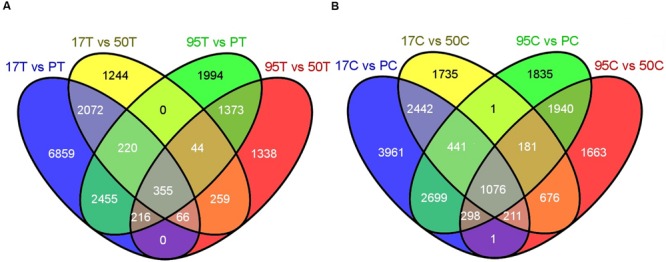
(A) Number of differentially up-regulated (DUR) transcripts in inoculated resistant lines (17T and 95T) compared to the inoculated susceptible lines (PT and 50T). (B) Number of DUR transcripts in uninoculated resistant lines (17C and 95C) compared to the uninoculated susceptible lines (PC and 50C). 17, 50, 95 and P refer to NE BG 7-3459-17, NE BG 7-3453-50, 95-55 and Prestige, respectively. C and T indicate untreated and treated samples, respectively. The Venn diagrams were generated by the Venny tool (http://bioinfogp.cnb.csic.es/tools/venny/) using the DUR transcripts resulting from DESeq2 by comparing each resistant and susceptible line.